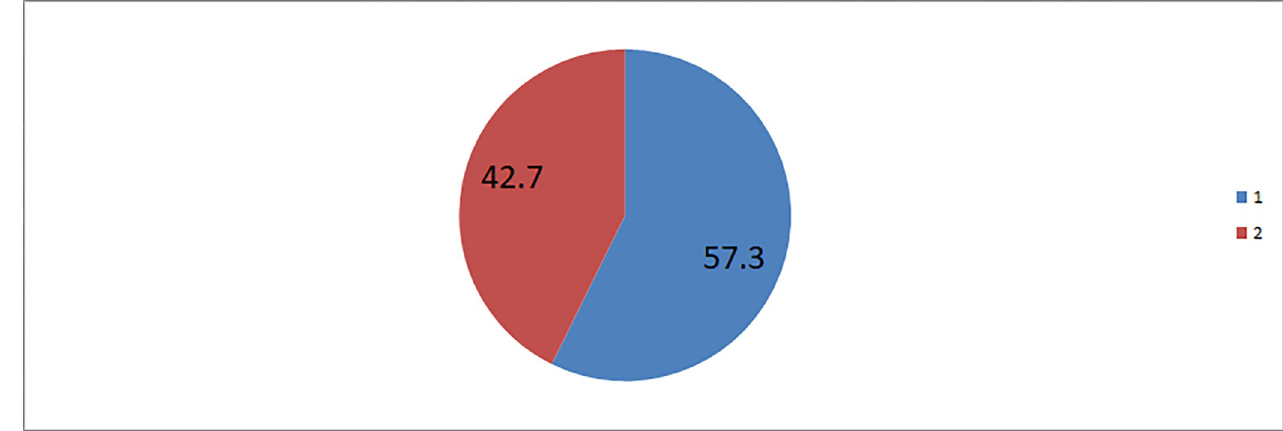
Fig 2. Attitude towards COVID-19 vaccination among pregnant women in Motta town and Hulet Eji Enese district, northwest Ethiopia, 2021. 1 = Negative attitude towards COVID-19 vaccination during pregnancy, 2 = Positive attitude Towards COVID-19 vaccination during pregnancy.